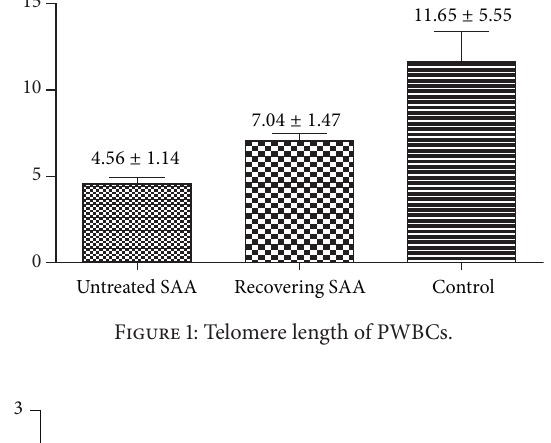
Table 4: Telomere length of SAA patients and